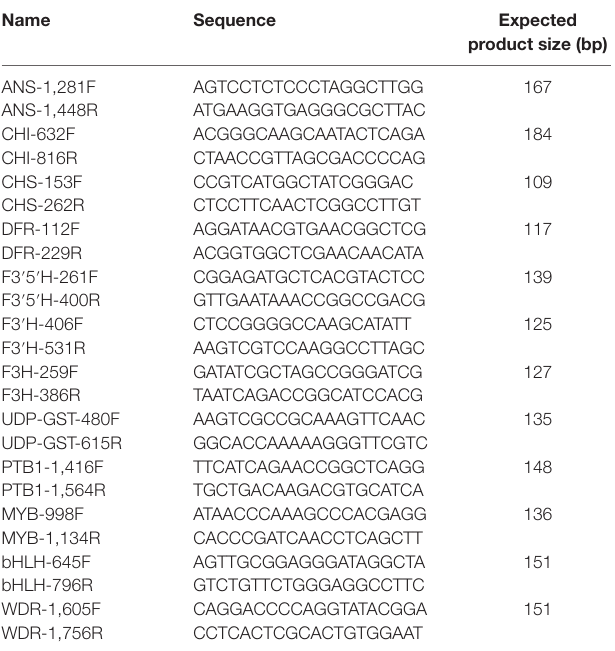
TABLE 1 | The primers used for RT-qPCR of the genes of the anthocyanin biosynthesis pathway and its transcription factors (Le Maitre et al., 2019). Name